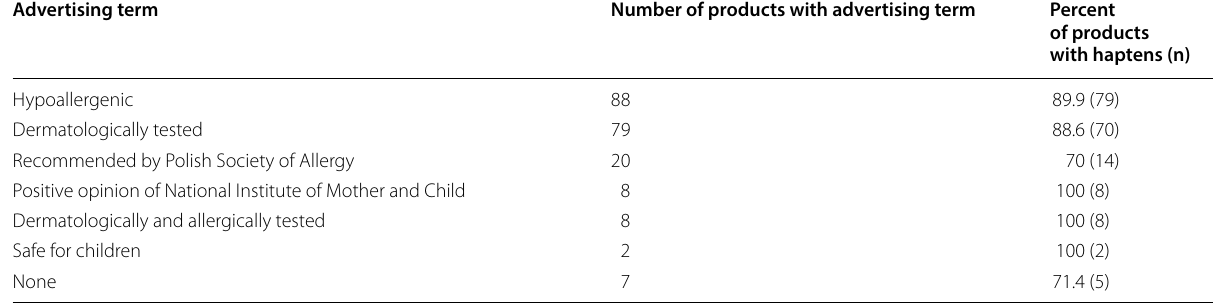
Table 2 Market terms used by manufacturers to prove safety of cosmetics for newborns and infants Advertising term